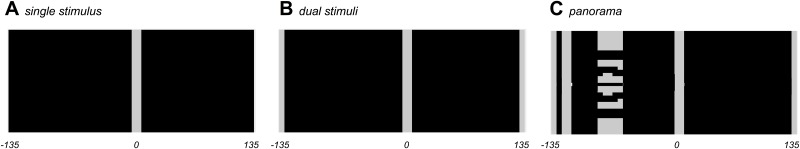
Stimuli for the model.A Single stimulus. B Dual stimuli. C Panorama of stimuli. These stimuli are based on the angular dimensions of the layouts used by Seelig and Jayaraman [11].